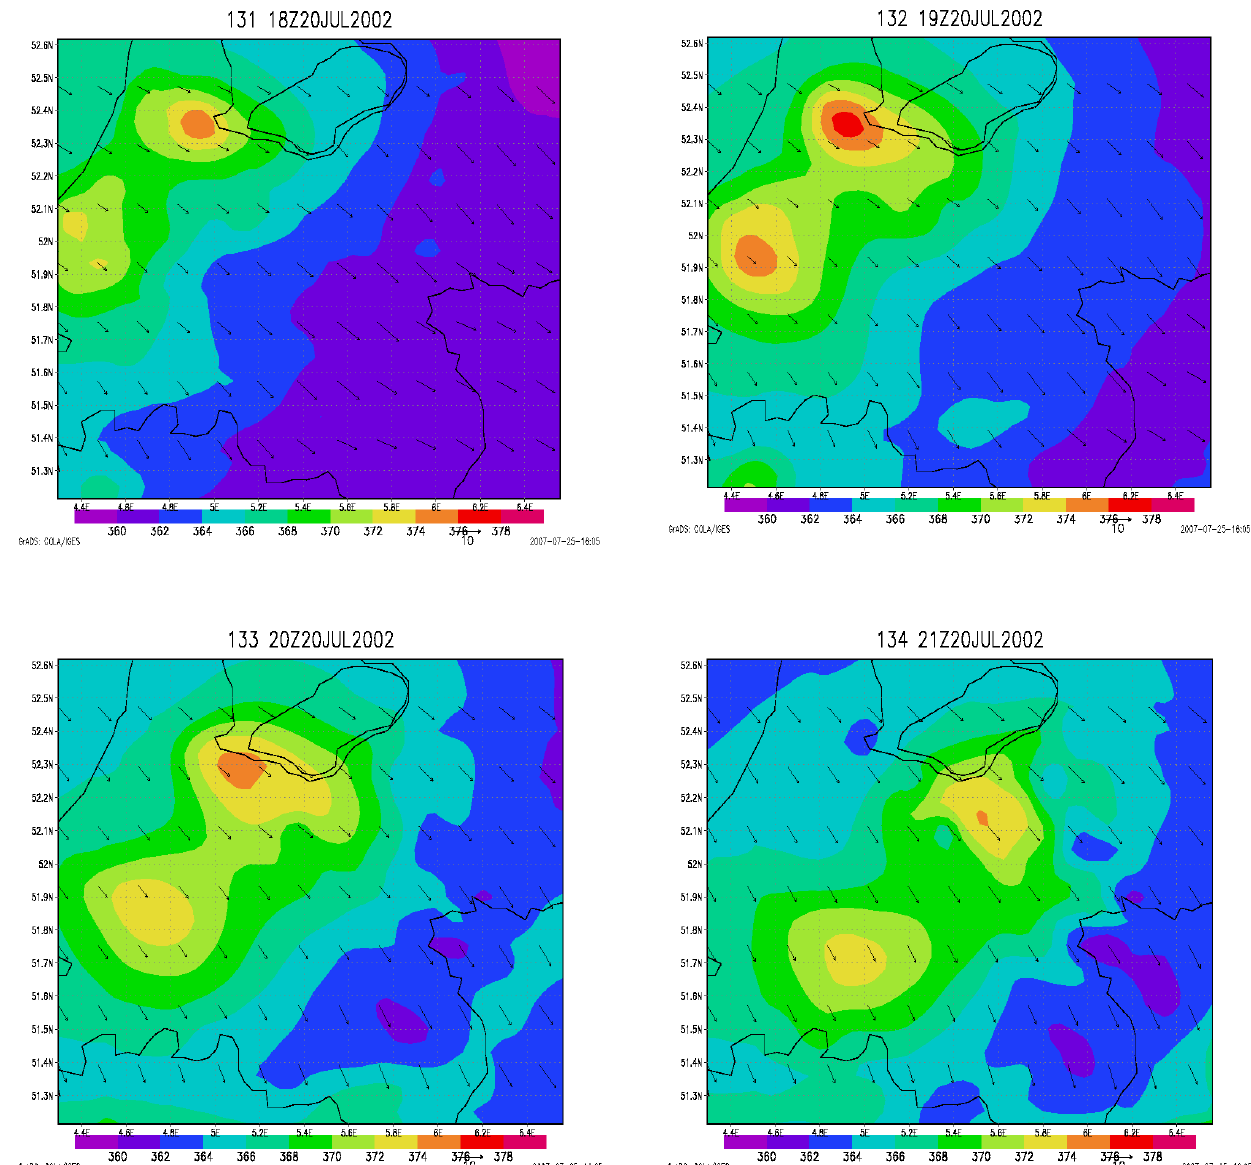
Fig. 18. Example of CO 2 transport: snapshots of [CO 2 ] (ppm) at the lowest model level for 4 different times on 20 July 2002 (top left – bottom right: 18:00GMT–21:00GMT with hourly